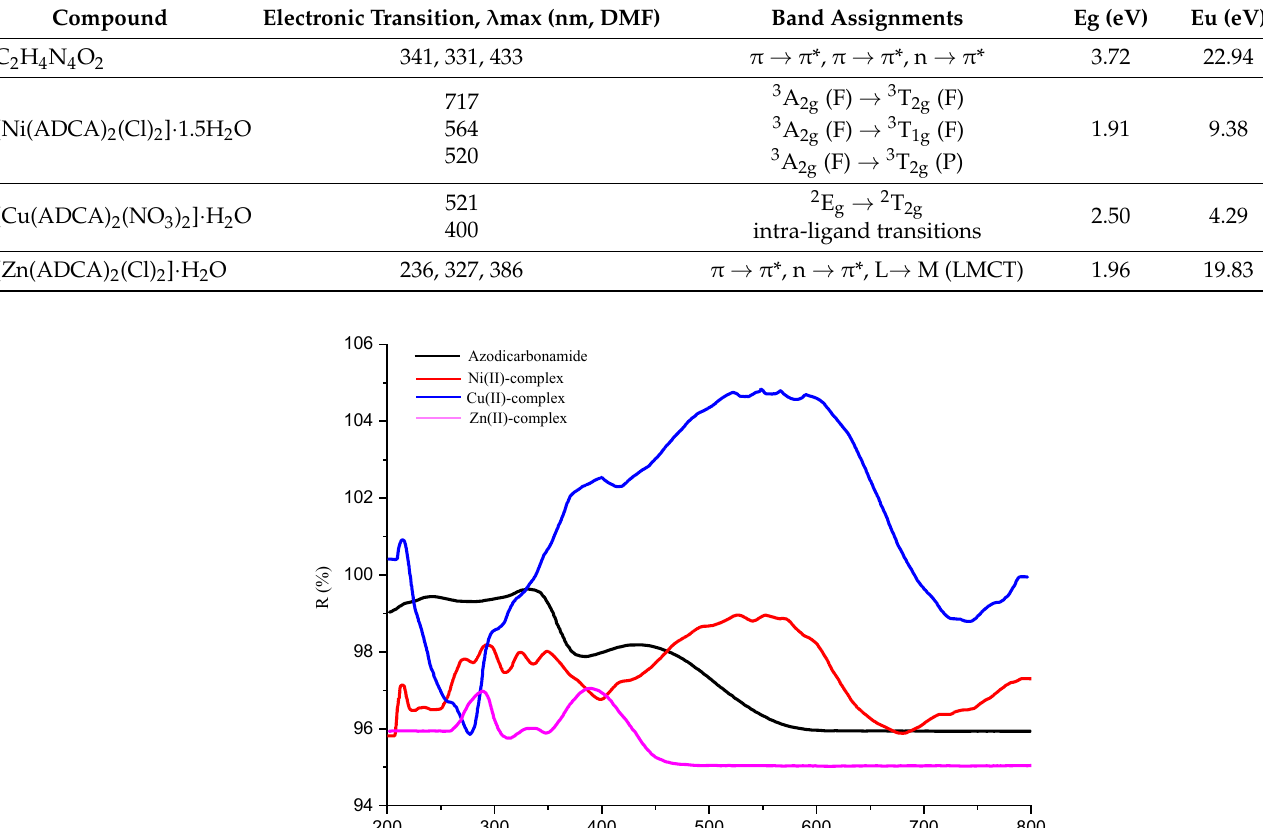
Table 4. Absorption data and band assignment of azodicarbonamide ligand and its complexes.